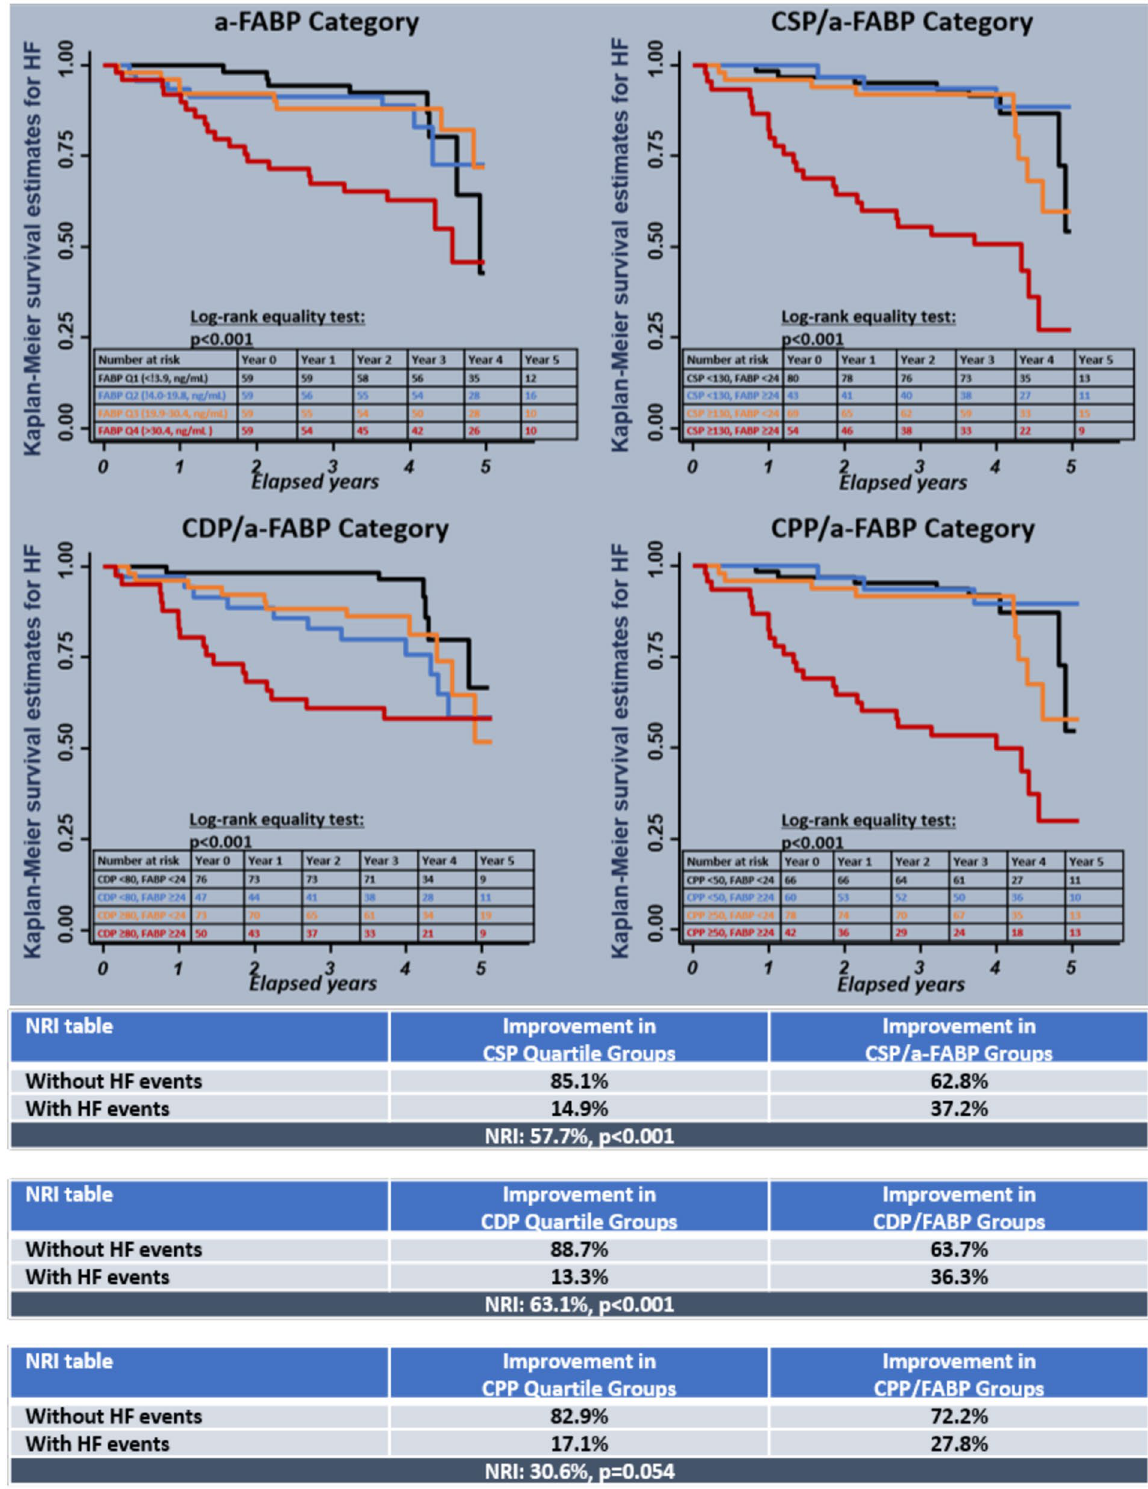
Figure 4. Kaplan–Meier survival analyses exhibited event free survival curves of incident HF when subjects were divided into a-FABP for four quartiles: CSP (130 mm-Hg) vs. a-FABP (24 pg/mL), CDP: (80 mm-Hg) vs. a-FABP (24 ng/mL), and CPP (50 mm-Hg) vs. a-FABP (24